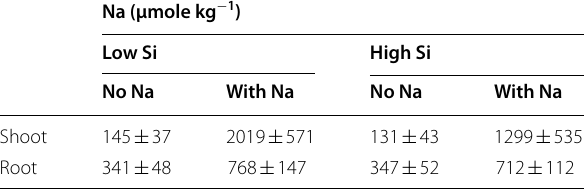
Plants were grown in hydroponics for 30 d at low (0.07 mM) and high (1 mM) ambient Si, with (50 mM NaCl) or without (0 mM NaCl) salt stress. Table show means with standard deviations. N =